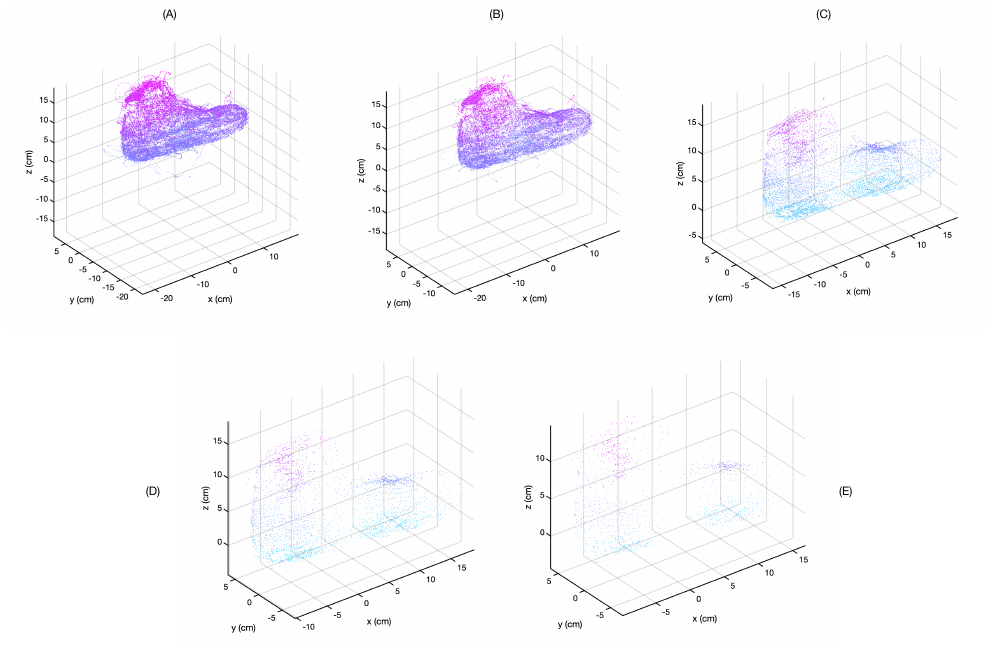
Figure 6. The effect of filtering. As the angular resolution of the filter decreases, the number and extremity of the outliers decreases. However, the total number of data points decreases sharply and the image resolution becomes poorer. The resolutions are, in order from ( A – E ): 0.25 ◦ , 1 ◦ , 3 ◦ , 5 ◦ , and 8 ◦ .